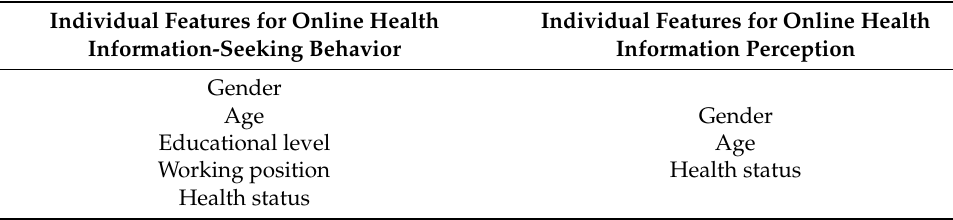
Table 1. Individual features considered for the